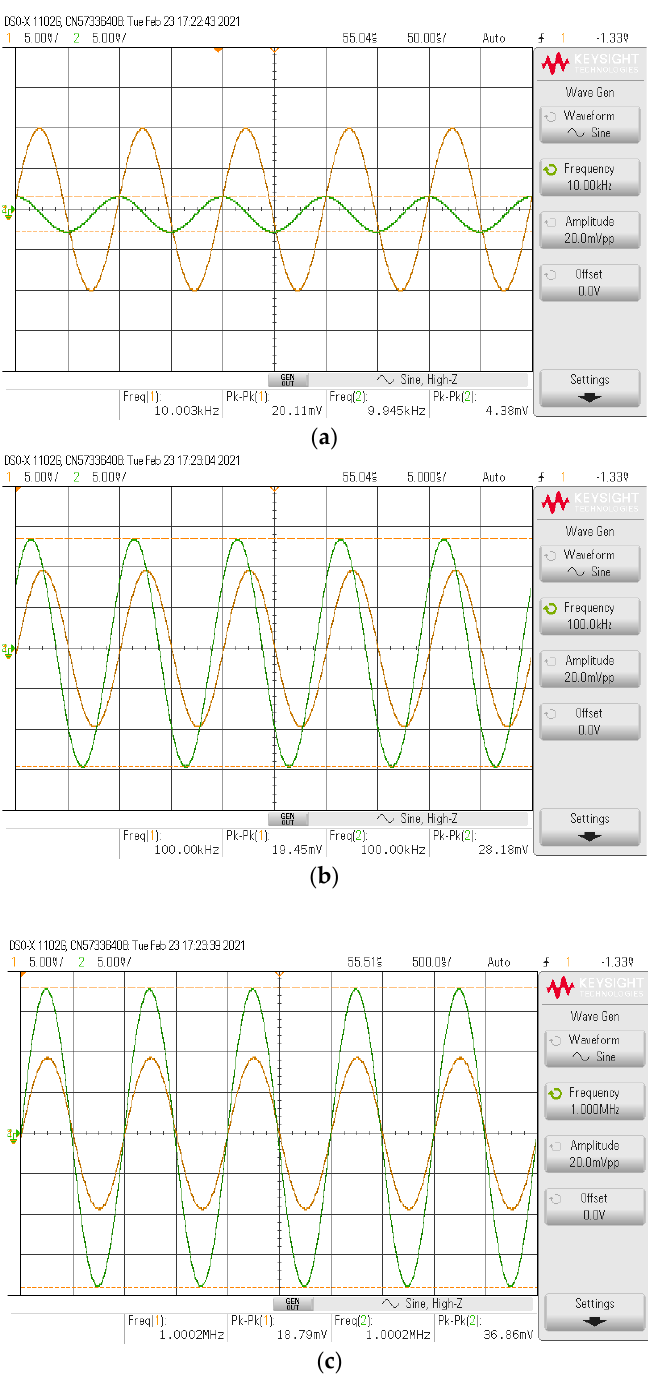
Figure 11. Measured input and output waveform of HP ( ‐‐‐‐ v in , ‐‐‐‐‐ v o ) where I B = 124.5 μ A. ( a ) f = 10 kHz. ( b ) f = 100 kHz. ( c ) f = 1 MHz. Figure 12 shows the simulated and experimental results of the gain and phase re ‐ sponses of the LP filter by applying voltage input to node v in 2 and connecting nodes v in 1 and v in 3 to ground, as indicated in Table 2. The simulated and experiment pole frequency are 87.63 kHz and 91.20 kHz, respectively. The percent errors of the simulated and exper ‐ imental pole frequency were 2.63% and 1.33%, respectively. The simulated and experi ‐ mental pass ‐ band voltage gain were 1.98 (5.92 dB) and 1.99 (6.01 dB), respectively. The percent errors of the simulated and experimental pass ‐ band gains were 1% and 0.5%, re ‐ spectively. The simulated and experimental phase angles at the pole frequency were − 45.76° and − 44.34°, respectively. The percent errors of the simulated and experimental phase angles were 1.69% and 1.47%, respectively.